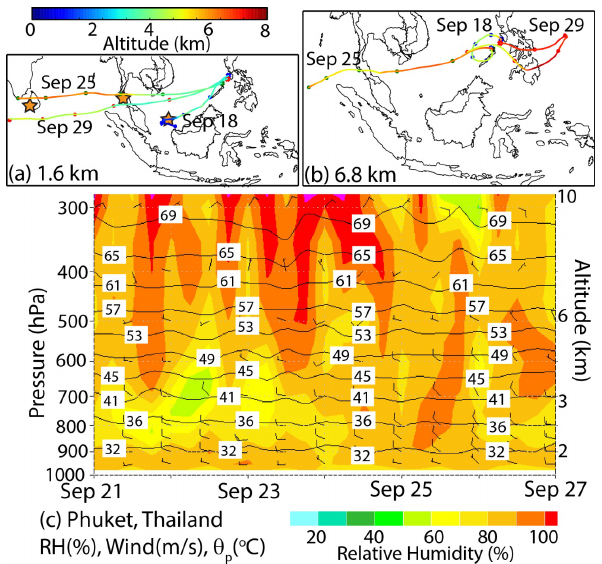
Figure 9. Back trajectories and time height cross sections. (a, b) 1.6km and 6.8km back trajectories from the Vasco for the cases posted in Fig. 11. (c) Time height cross section for Phuket, Thai- land, of relative humidity color (RH) with potential temperature isopleths ( ◦ C). Wind barbs are given with full and half bar at 10 and 5ms − 1 , respectively.